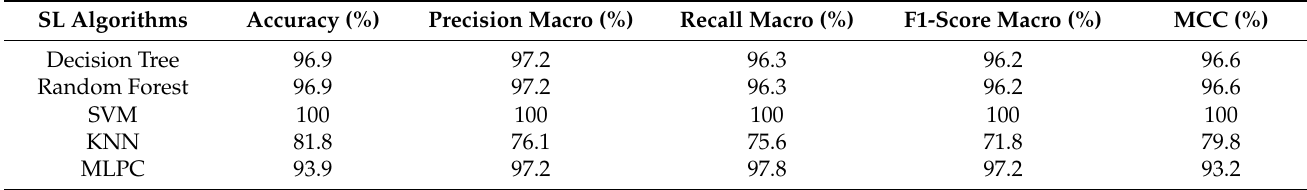
Table 6. Model metric results for the second simulation (KPIs + KQIs).